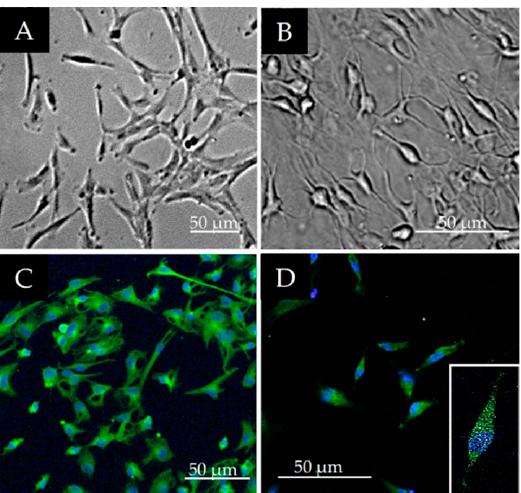
Figure 4. ( A,B ) morphological changes during neuronal differentiation of DPSCs. Phase contrast microscopic images on day 0 ( A ) and on day 12 of neurogenic differentiation ( B ). ( C,D ) expression of neuronal/glia markers in DPSCs after 12 days of differentiation: β -tubulin III (C) and glial GFAP intermediate filament protein (D).